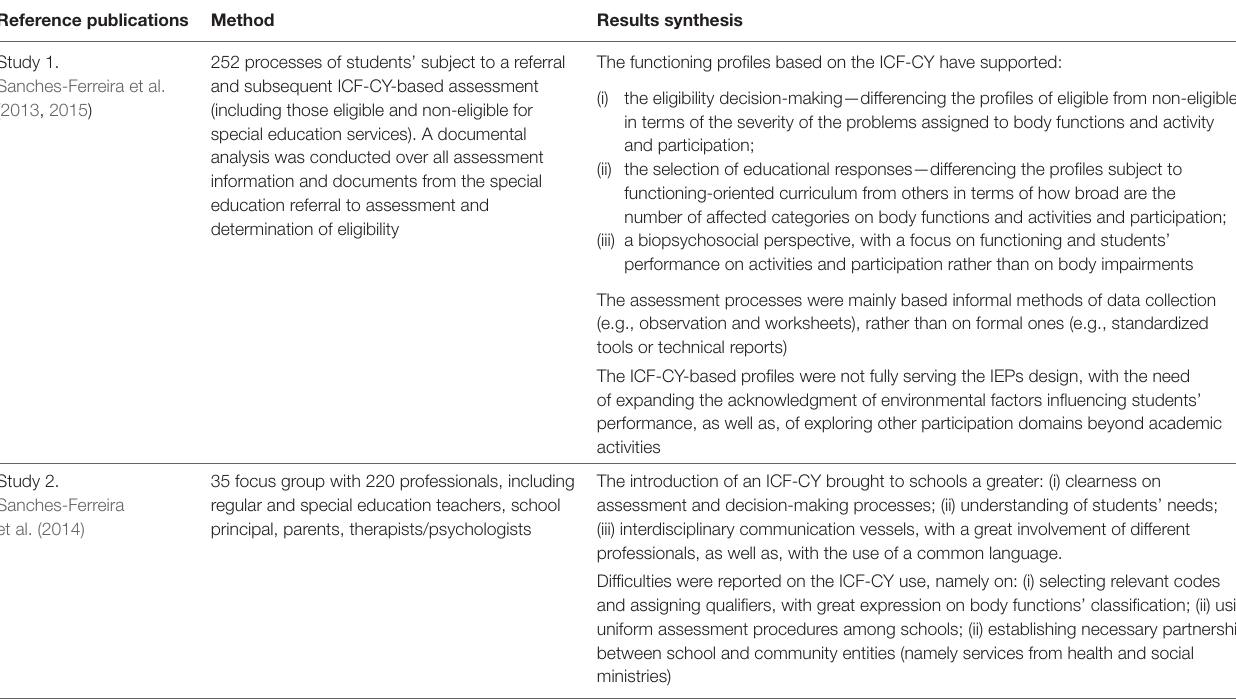
Table 1 | Review of the first two studies about the evaluation of the implementation of the Law No.